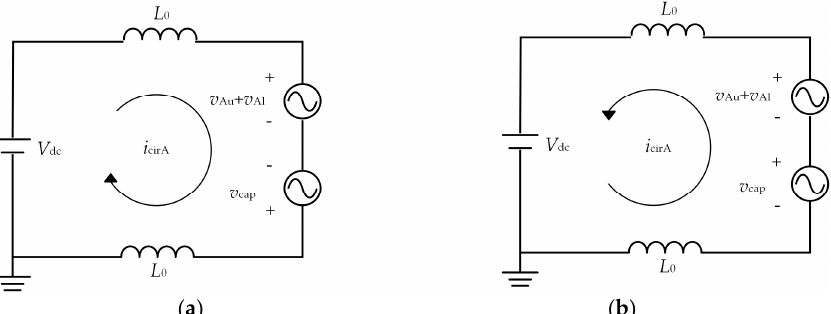
Figure 11. The DC-side equivalent circuit of the MMC. ( a ) N − 1 sub-modules are switched in for phase A, ( b ) N +1 sub-modules are switched in for phase A.